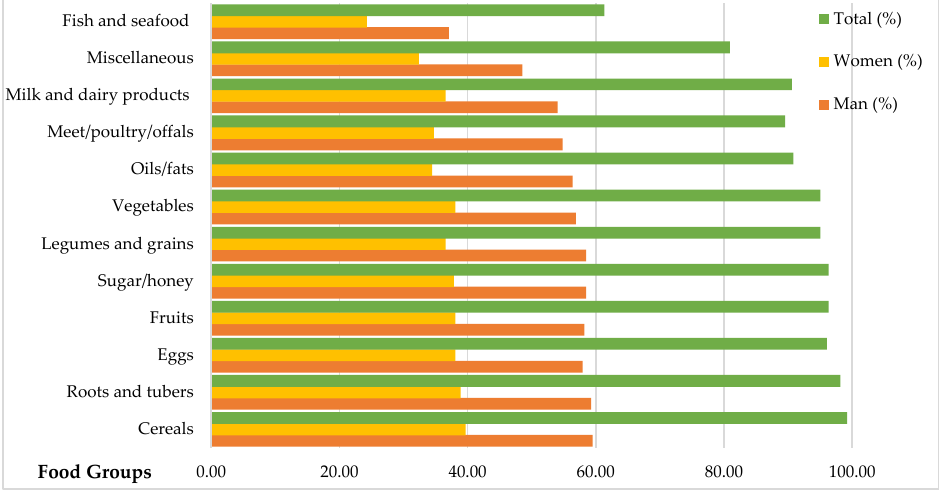
Figure 2. Total percentage of households that consumed each food group in 2019 and percentage broken down by the sex of the head of household. Note: n =383 households. Source: Author’s own elaboration from surveys, 2019.